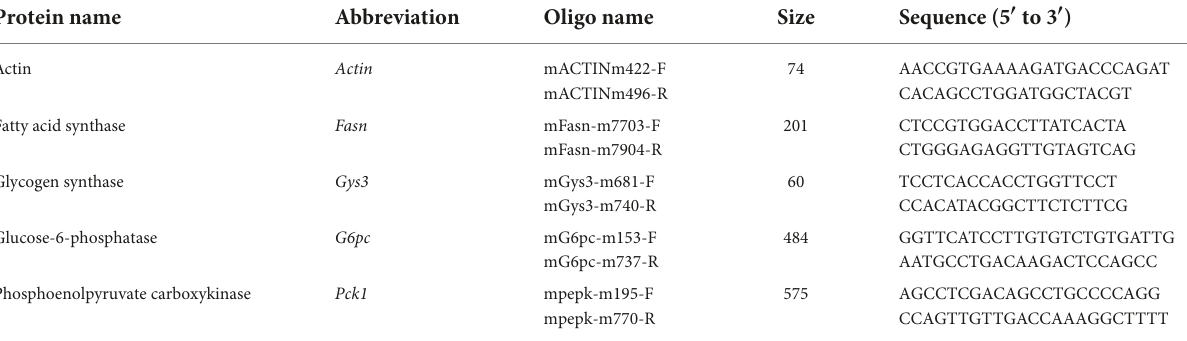
TABLE 3 Primer sequences of target proteins used in real-time PCR mRNA